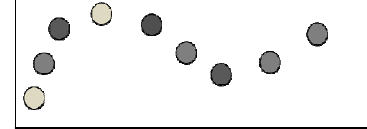
Fig. 11. Law of continuity.